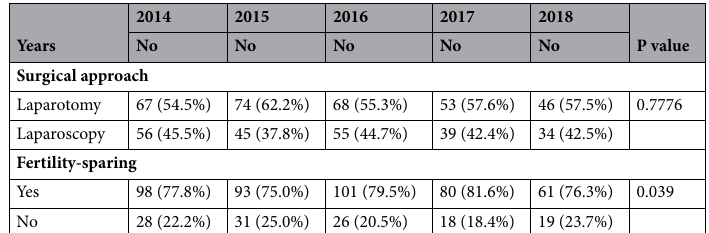
Table 2. Annual trends in surgical approach and fertility-sparing surgery.